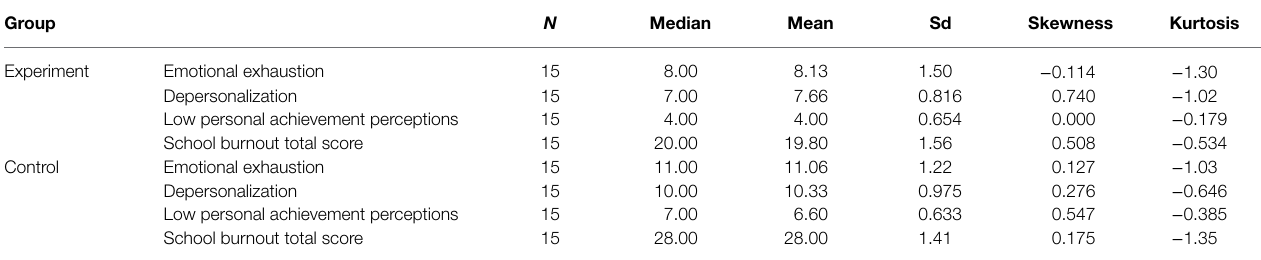
TABLE 2 | Post-test descriptive statistics and skewness-kurtosis values of experimental and control groups on emotional exhaustion, depersonalization, low achievement perception, total burnout score. Group N Median Skewness Experiment Emotional exhaustion